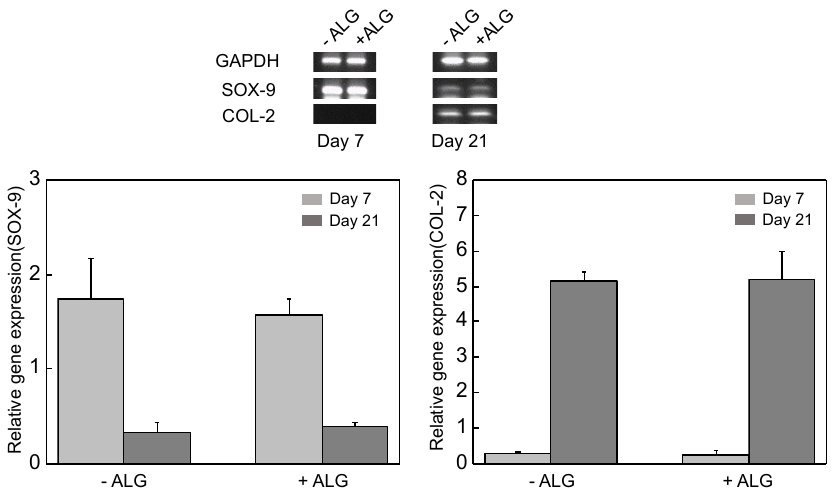
Figure 6. ( a ) Images of live and dead cells encapsulated within OHA/GC/ADH/ALG hydrogels before and after printing process. Secondary cross-linking of the gels was carried out with calcium ions (+Ca 2+ ), and non-cross-linked gels were also used ( − Ca 2+ ). ( b ) Quantitative results from live/dead assays.